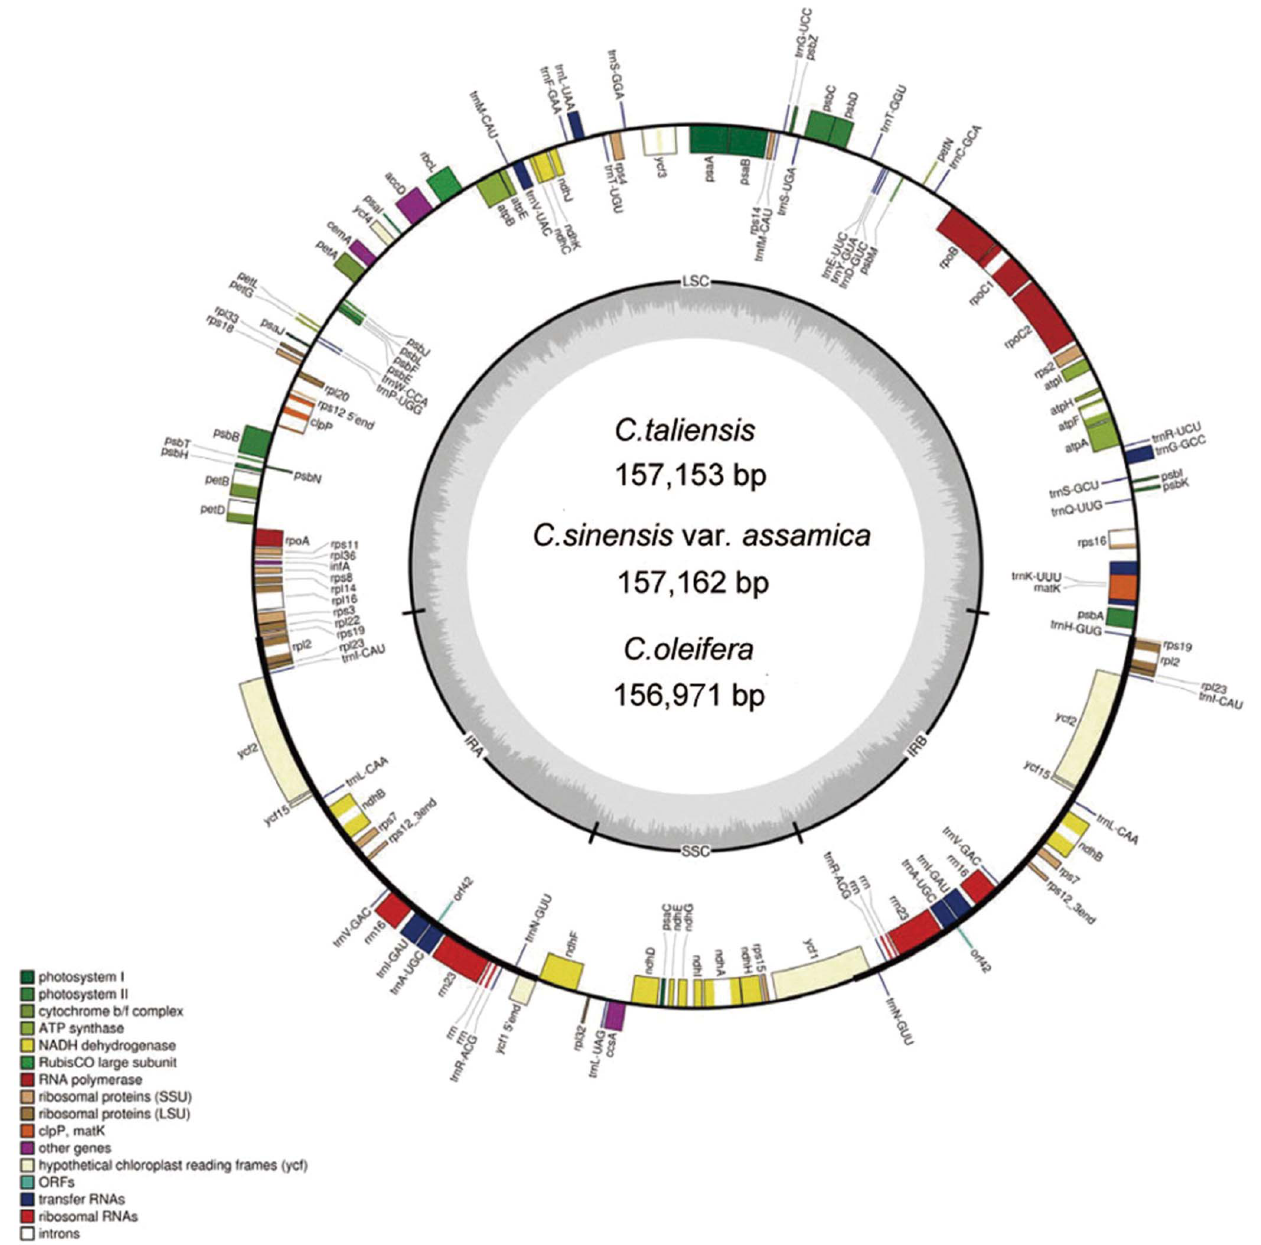
Figure 1. The map of the three Camellia chloroplast genome sequences. Genes on the outside of the map are transcribed in the clockwise direction and genes on the inside of the map are transcribed in the counterclockwise direction. Dashed area in the inner circle indicates the GC content of the chloroplast genome.